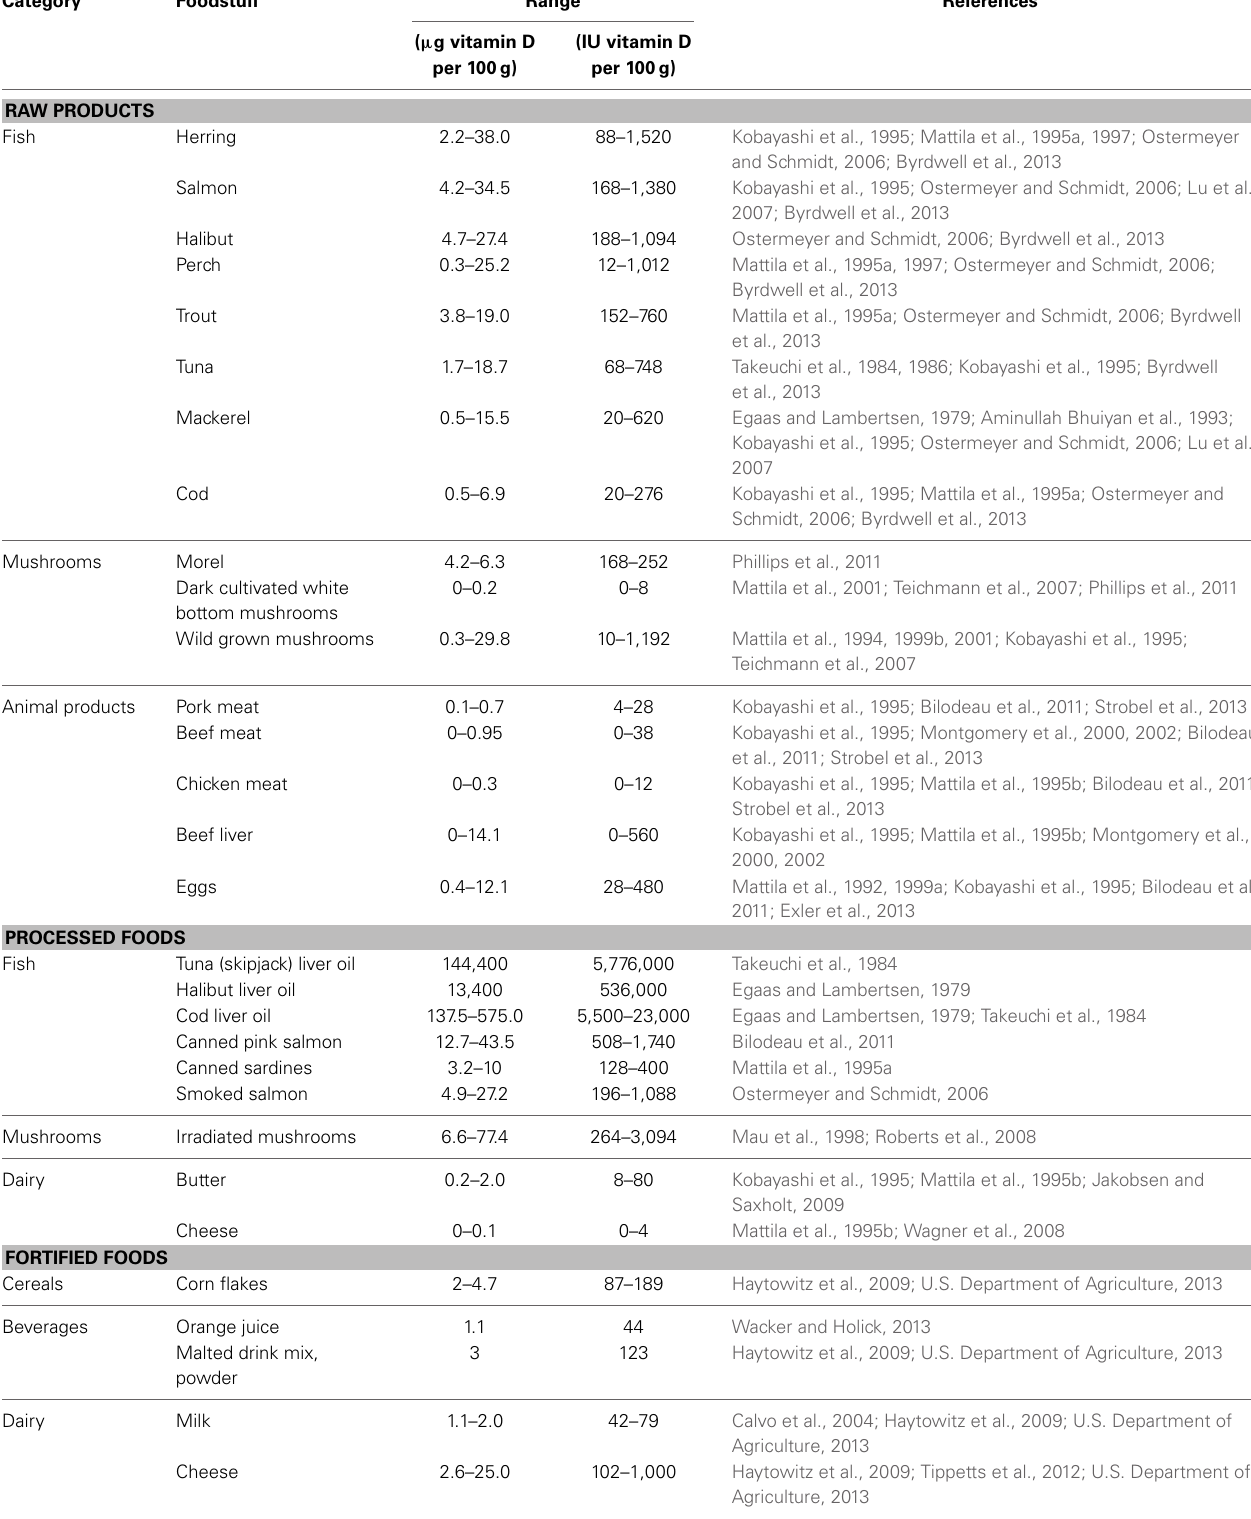
Table 1 | Vitamin D content in raw products, processed foods, and fortified